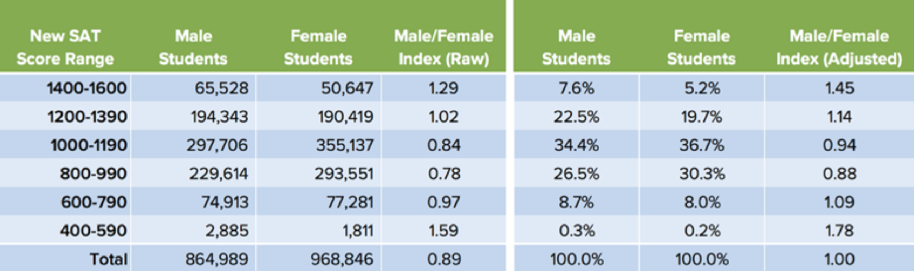
Figure 2. Figure from [13], p. 7, titled “The numbers College Board didn’t publish” showing statistics for nearly two million students for the 2016 Edition of the Scholastic Aptitude Test, with breakdown by gender and score ranges. Note that the proportions of males in various score ranges, i.e., the tail ratios , increase as the score range increases and the left tail ratios also increase as the score range decreases.(About 10% more females participated than males, which is reflected in the Adjusted Male/Female